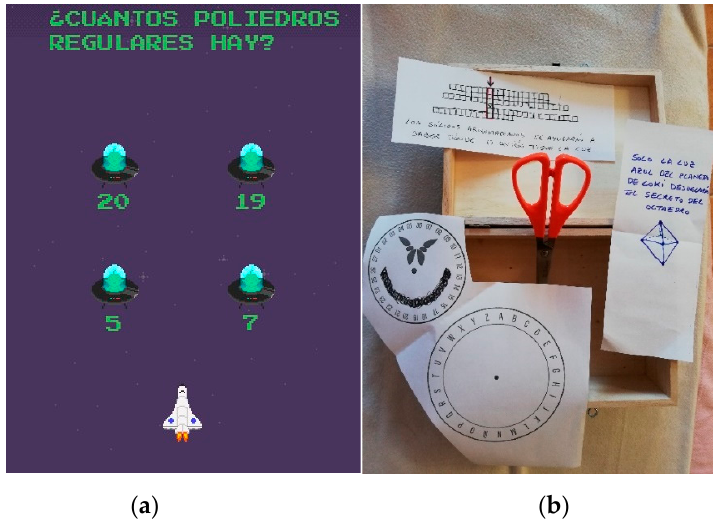
Figure 12. ( a ) students doing truncated polyhedra with polydron game; ( b ) truncated icosahedron with AR; ( c ) truncated icosahedron with polydron game. Some images of Breakout EDU from session 12 are shown below.